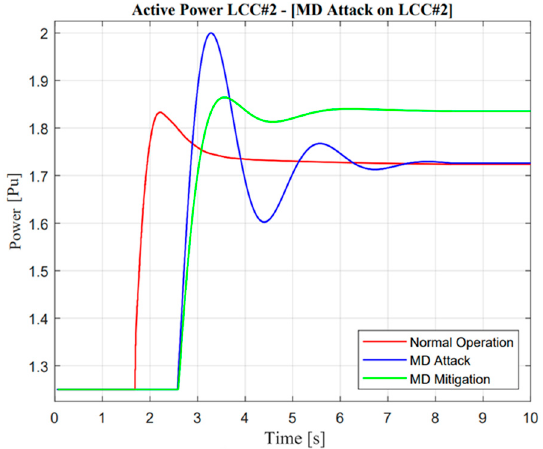
Figure 22. LCC active power response in the missing data attack operation.